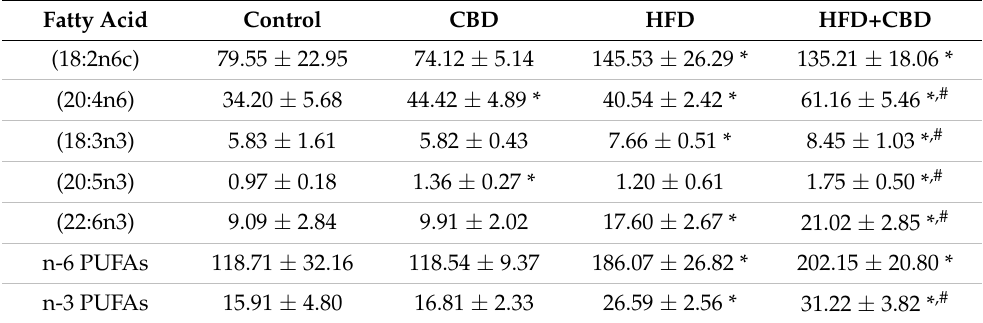
Table 4. Polyunsaturated fatty acids (PUFA) content in the DAG fraction (nmol/g of wet tissue) in the red gastrocnemius muscle in the control (standard diet) and high-fat diet (HFD) groups after two-week cannabidiol (CBD)